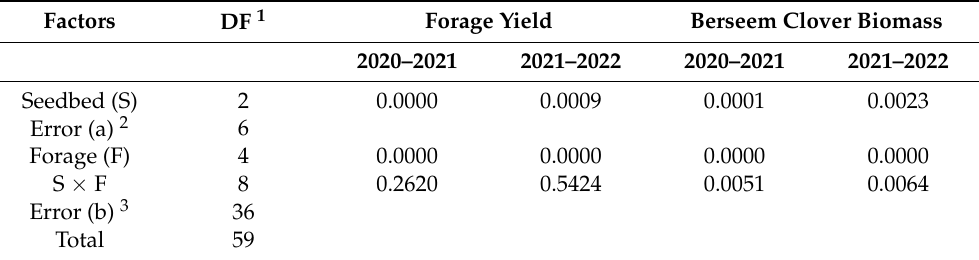
Table 7. Overall statistical analyses of degrees of freedom (for seedbed factor; for forage factor; for seedbed and forage interaction; for the error) and of the significance of effect (seedbed; forage; seedbed and forage interaction and tests performed) on cumulative forage yield and biomass of berseem clover from two harvests. Data are presented separately for the two growing